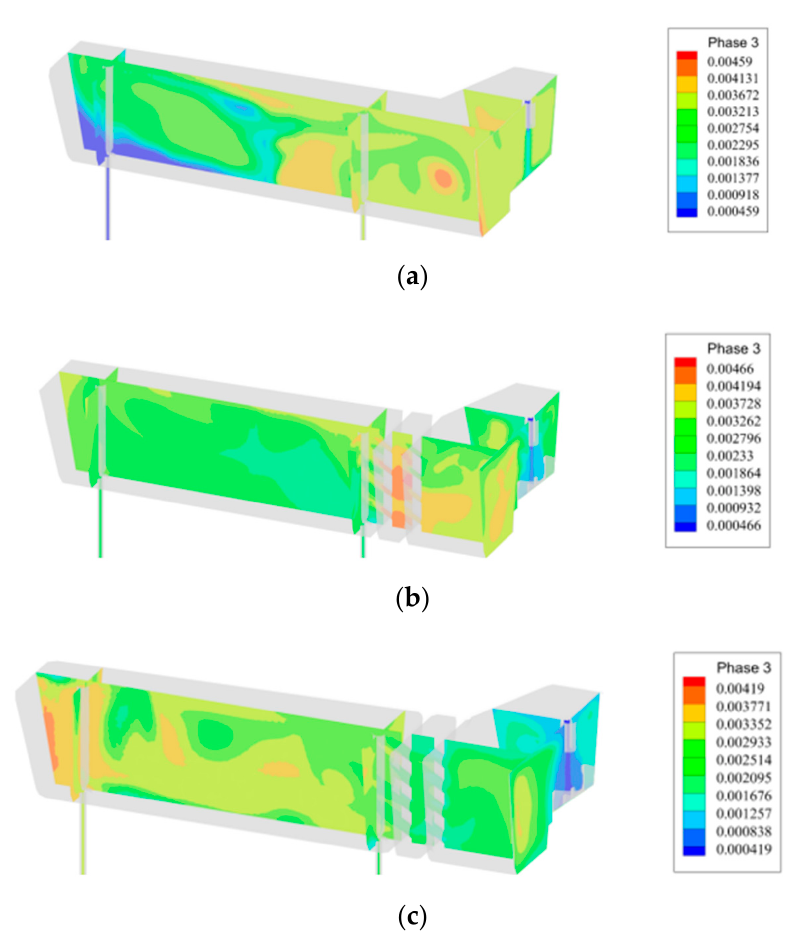
Figure 10. Tracer concentration display. ( a ) Scheme 0; ( b ) Scheme 6; and ( c ) Scheme 10. Comparing Scheme 0 (Figure 11a) and Scheme 10 (Figure 11b) of the top surface velocity of the injection zone, it can be seen that the high-speed injection forms a swirling flow between the internal blocks of the IRS structure, and forms an offset with subsequent injections. As a result, the flow velocity of the molten steel flow turning to reach the steel slag interface is significantly slowed. The average velocity of the molten steel reaching the outlet flow zone through the DPRW structure’s guide hole acceleration effect is still lower than that of Scheme 0, which effectively prolongs the mixing time of the molten steel in the tundish and reduces the liquid level in the injection zone. The liquid level fluctuation and slag entrapment in the injection zone are also effectively